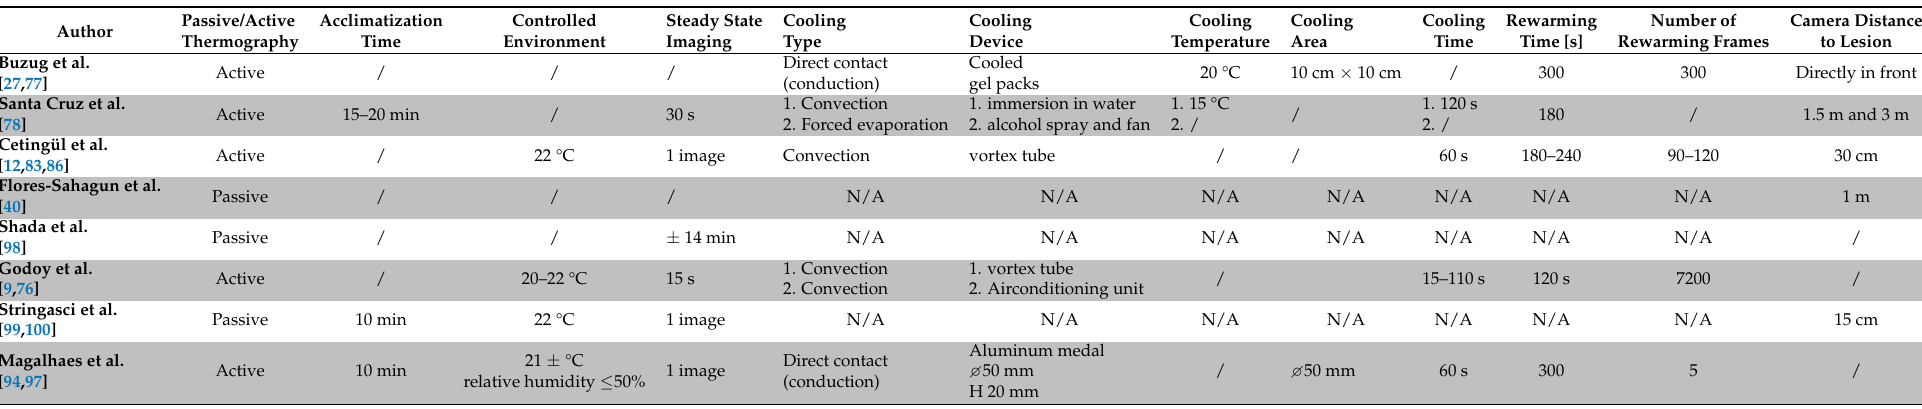
Table A2. Acquisition protocols used in literature.